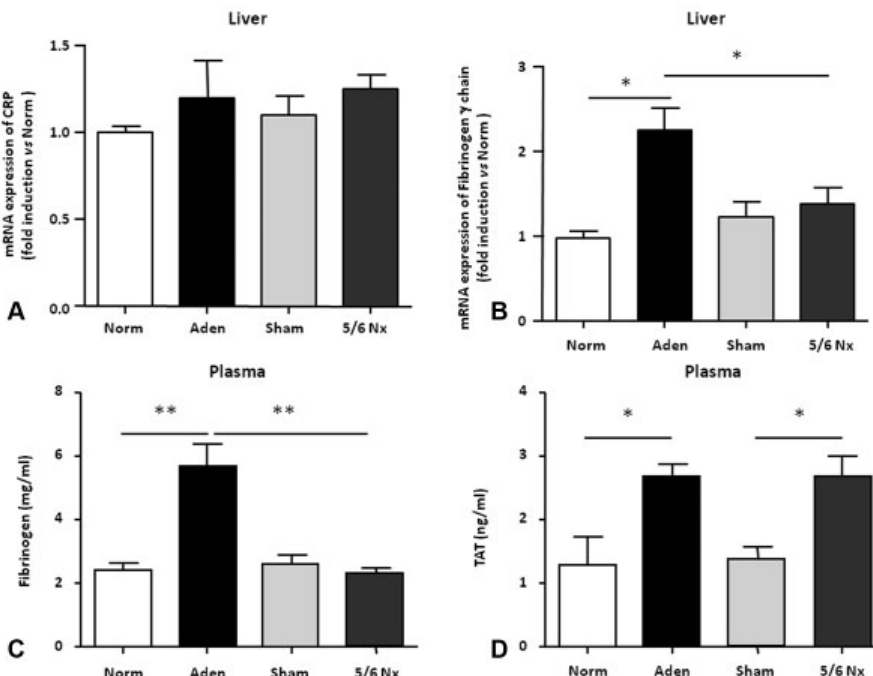
Fig. 2 Systemic in fl ammation and hypercoagulability in mice with CKD. CRP ( A ) and fi brinogen γ chain mRNA expression ( B ) in the liver isolated from mice fed with adenine 0.25% (Aden) or with Norm and from sham- or 5/6Nx-operated mice. Fibrinogen ( C ) and TAT complexes ( D ) concentrations were measured in the plasma of CKD mice (Aden and 5/6Nx) and of their respective control (Norm and Sham). CKD, chronic kidney disease, CRP, C-reactive protein; mRNA, messenger ribonucleic acid; Norm, normal diet; Aden, adenine diet; Nx, nephrectomy; SEM, standard error of the mean; TAT, thrombi-antithrombin. Data are expressed as mean (cid:3) SEM, n ¼ 4 – 6/group ( A, B ); n ¼ 5 – 9/group ( C, D ). (cid:4) p < 0.05; (cid:4)(cid:4) p <